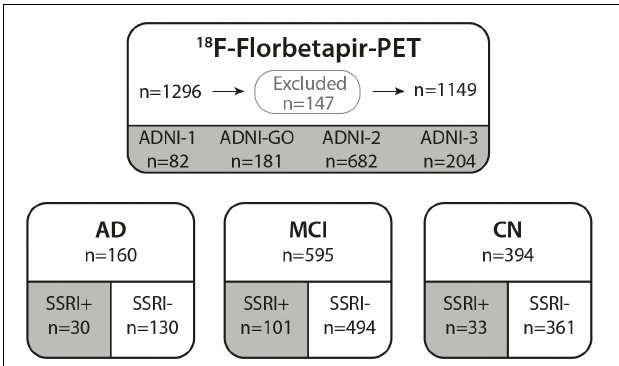
FIGURE 1 | ADNI cohort. 18 F-Florbetapir-PET was performed in n = 1296 ADNI participants. N = 147 subjects were excluded from our study due to missing data or stopped SSRI medication as well as patients with subjective memory deficits that did not meet criteria of AD or MCI. A total of n = 1149 subjects from ADNI phases 1, GO, 2 and 3 were included in this study. All subjects were categorized according to their diagnosis in AD, MCI, or CN. Groups were further subdivided in subjects with prior SSRI-treatment (SSRI + ) and subjects with no history of SSRI-treatment (SSRI − ). AD, Alzheimer’s dementia; MCI, mild cognitive impairment; CN, cognitively normal